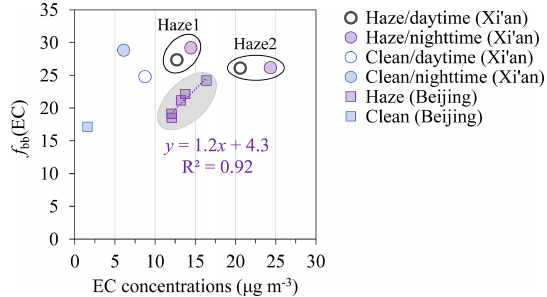
Figure 2. Scatter plot of the relative contribution of biomass burn- ing to EC ( f bb (EC); %) against EC